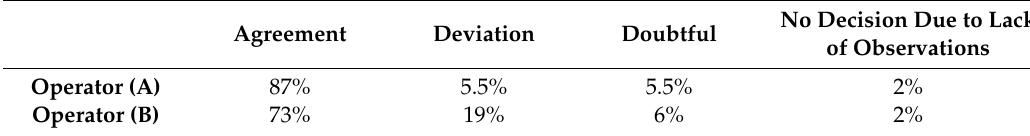
Table 1. Results from the visual assessment.